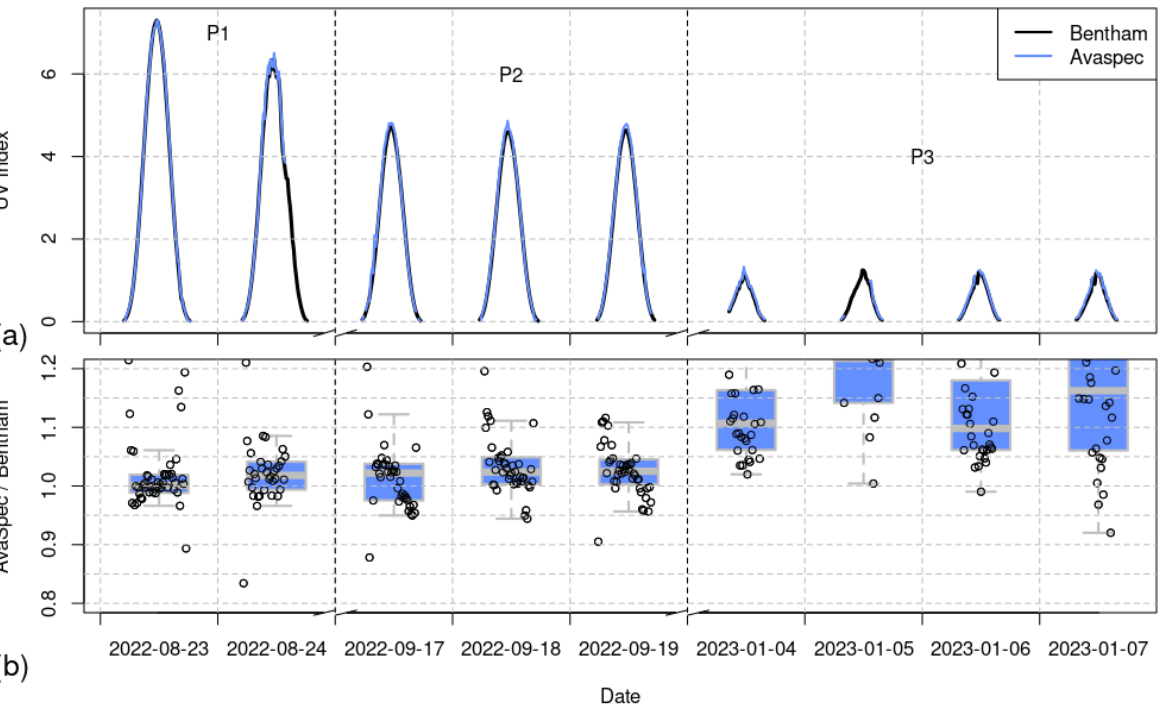
Figure 8. ( a ) UV index measured by the Bentham (reference) and the AvaSpec during the three intensive periods. All data were processed using the response determined on 23 August 2022. ( b ) Ratio between the UV index measured by the AvaSpec and the Bentham. Notice that: (1) all data are plotted (circles), even those collected at very large SZAs (morning/evening and winter) or with the sun behind the mountains; (2) some days have incomplete measurements (e.g., 24 August, 5 January), which could hinder the comparison. The coloured area of the boxplots in the background indicates the interquartile distance (25–75%), while the baffles represent the whole range of the data with the exception of the